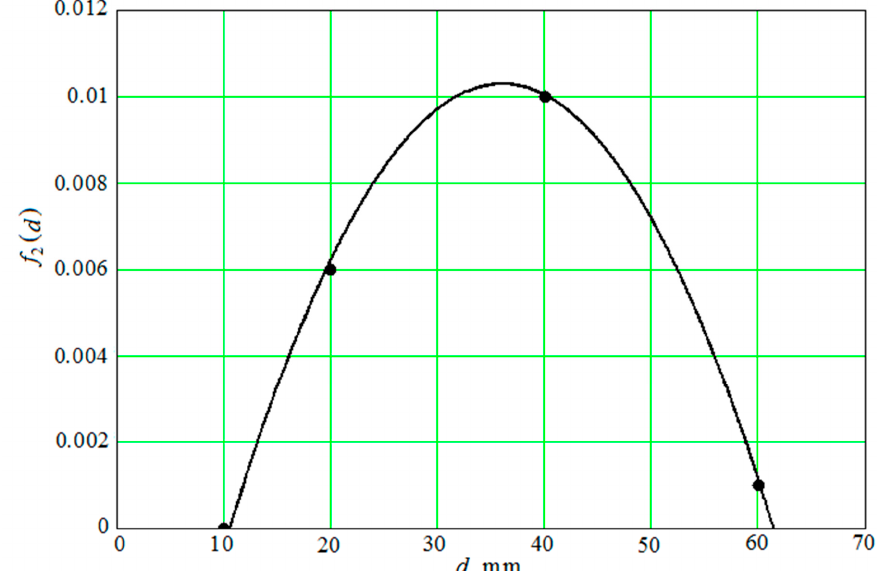
Figure 6. The function f 2 ( d ) (continuous curve) and the results of the numerical solution of Equation (41) (points). The root-mean-square relative deviation of the values that were calculated by the Equation (42) from the values obtained by the numerical solution of the Equation (41) is less than 6%.